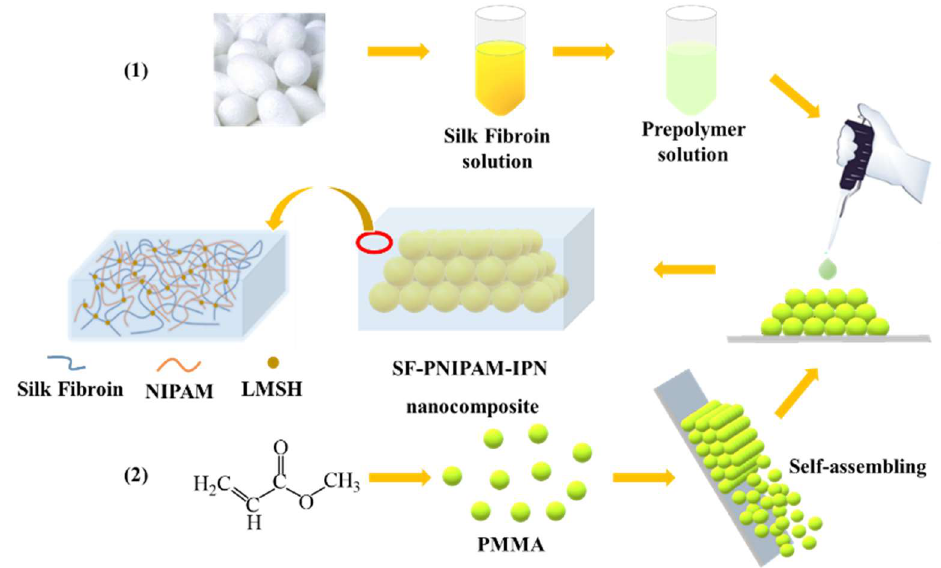
Figure 1. Scheme of crosslinking principle of the SF-PNIPAM dual-crosslinked nanocomposite based on purely physically crosslinking network.